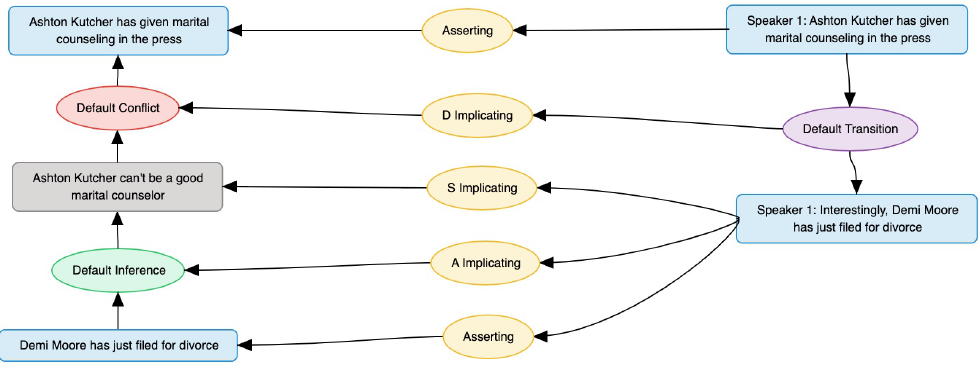
Figure 4. IAT CI diagram for Example